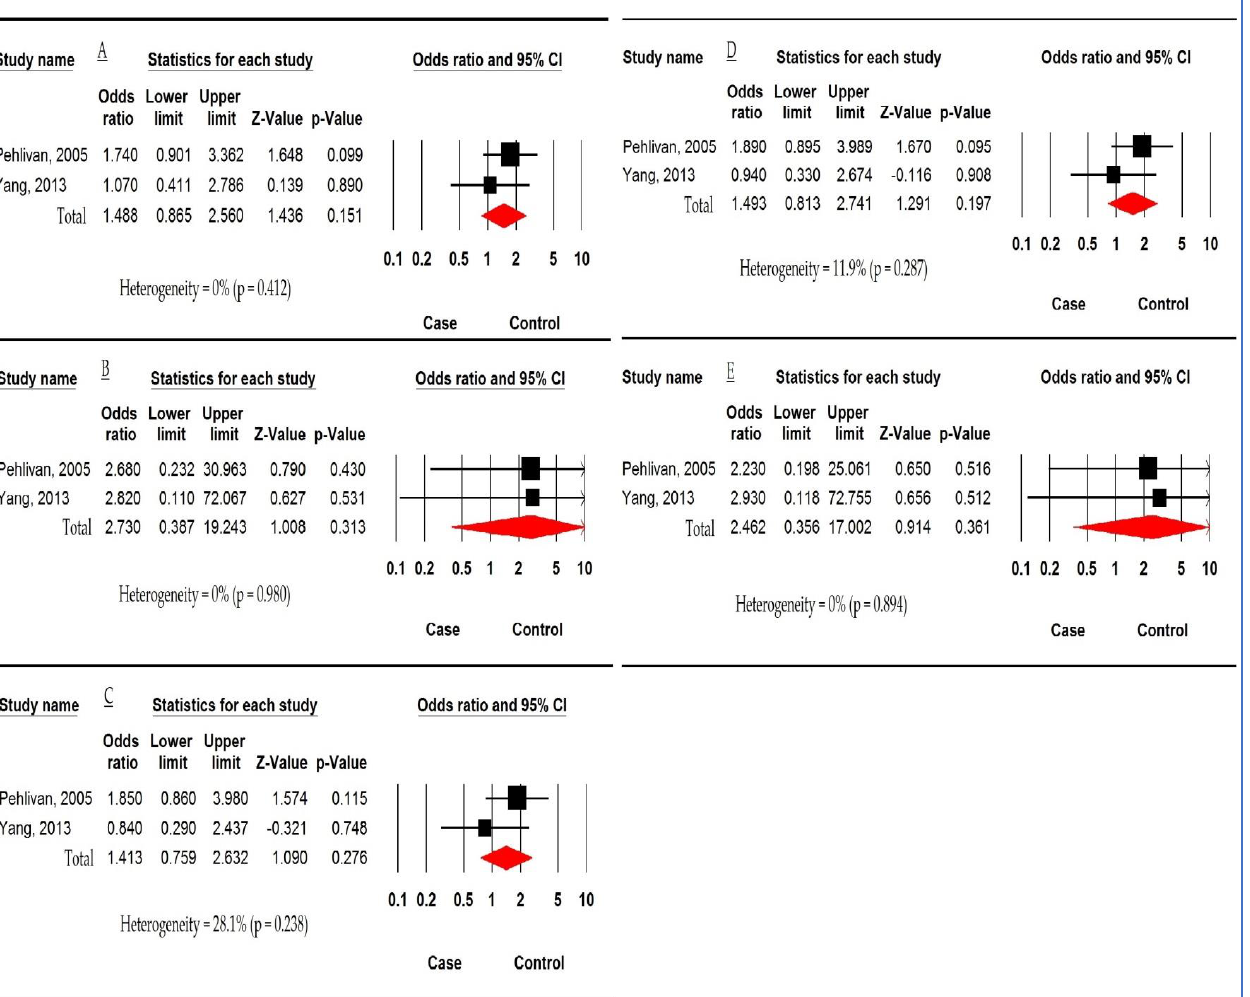
Figure 6. Forest plot for association between mannose-binding lectin 2 (MBL2) rs1800450 polymorphism and dental caries susceptibility. ( A ) Allelic model. ( B ) Homozygous model. ( C ) Heterozygous model. ( D ) Dominant model. ( E ) Recessive model